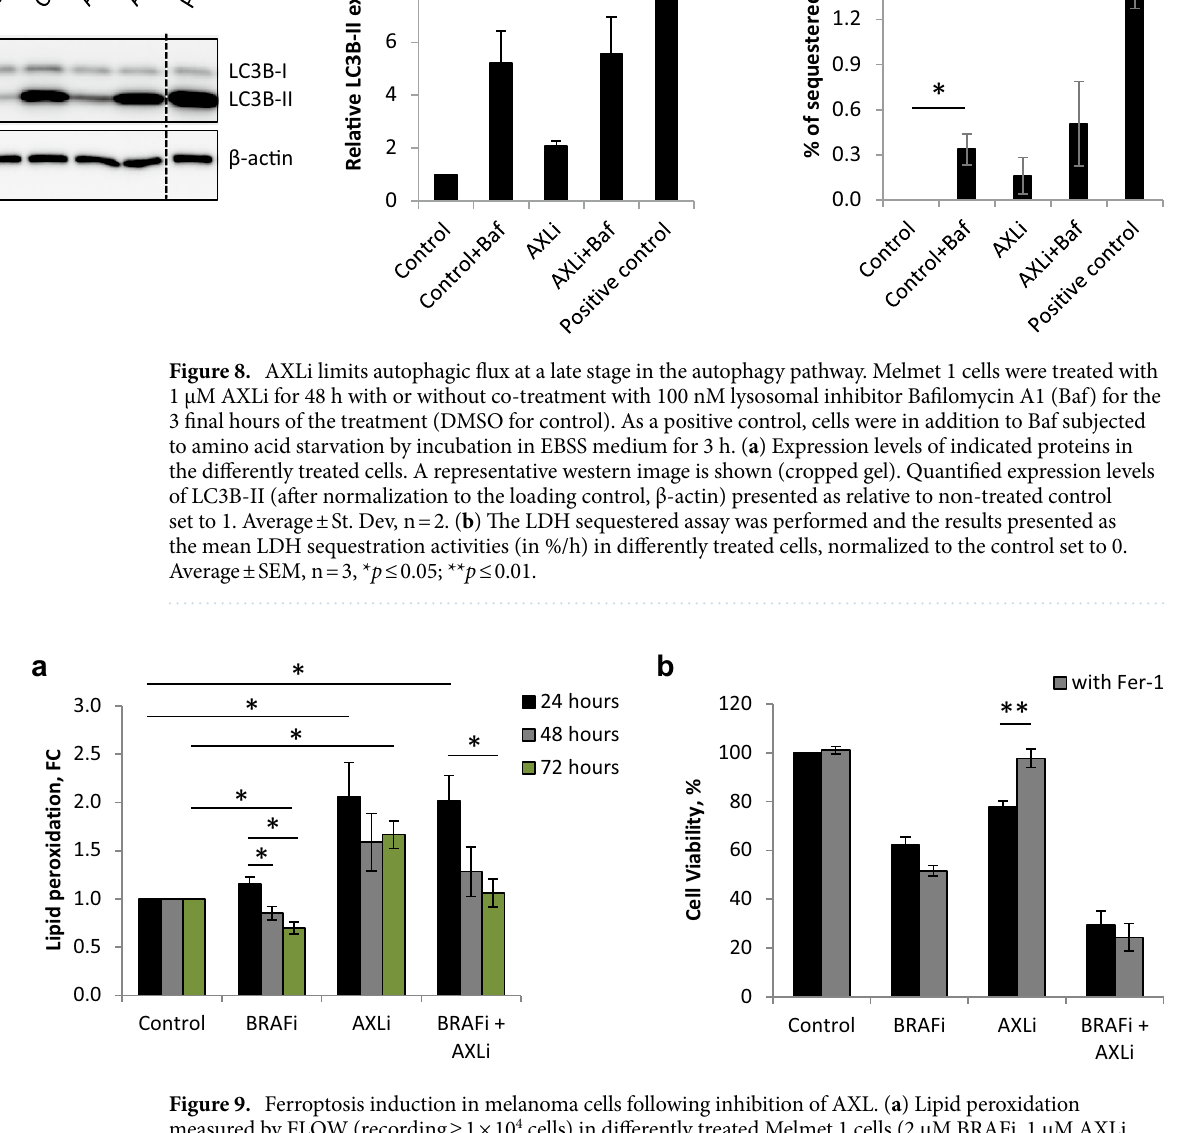
Figure 9. Ferroptosis induction in melanoma cells following inhibition of AXL. ( a ) Lipid peroxidation measured by FLOW (recording ≥ 1 × 10 4 cells) in differently treated Melmet 1 cells (2 µM BRAFi, 1 µM AXLi or a combination of both, DMSO for control) for 24–72 h and presented as a fold change (FC) between the detected red signal of lipid peroxidation sensor in treated samples compared to the respective non-treated controls set to 1. ( b ) Cell viability of Melmet 1 cells treated with 0.25 µM ferroptosis inhibitor ferrostatin-1 (Fer-1), 2 µM BRAFi, 0.5 µM AXLi or a combination of two/three compounds, DMSO for control, for 72 h. The treatment effect was scored by CTG assay and presented as % relative to the respective non-treated controls set to 100%. Average ± SEM, n = 3. * p ≤ 0.05; ** p ≤